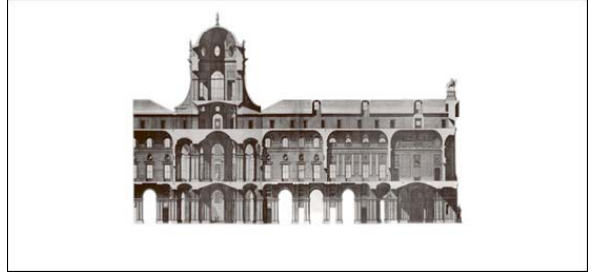
Figure 3. Part of the longitudinal section of the original design of the royal palace